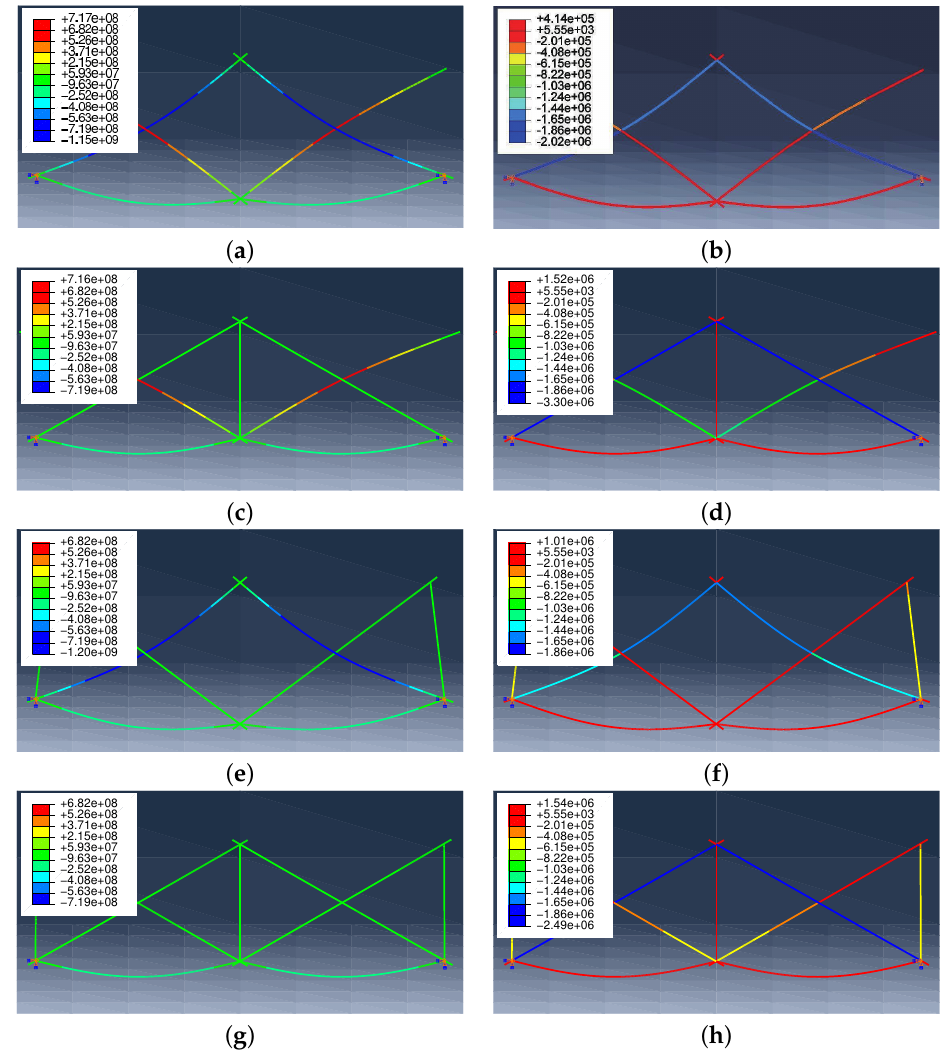
Figure 8. Numerical results in lower decks pattern (response magnification 100 times): ( a ) BMD in Case 1-1; ( b ) AFD in Case 1-1; ( c ) BMD in Case 1-2; ( d ) AFD in Case 1-2; ( e ) BMD in Case 1-3; ( f ) AFD in Case 1-3; ( g ) BMD in Case 1-4; ( h ) AFD in Case